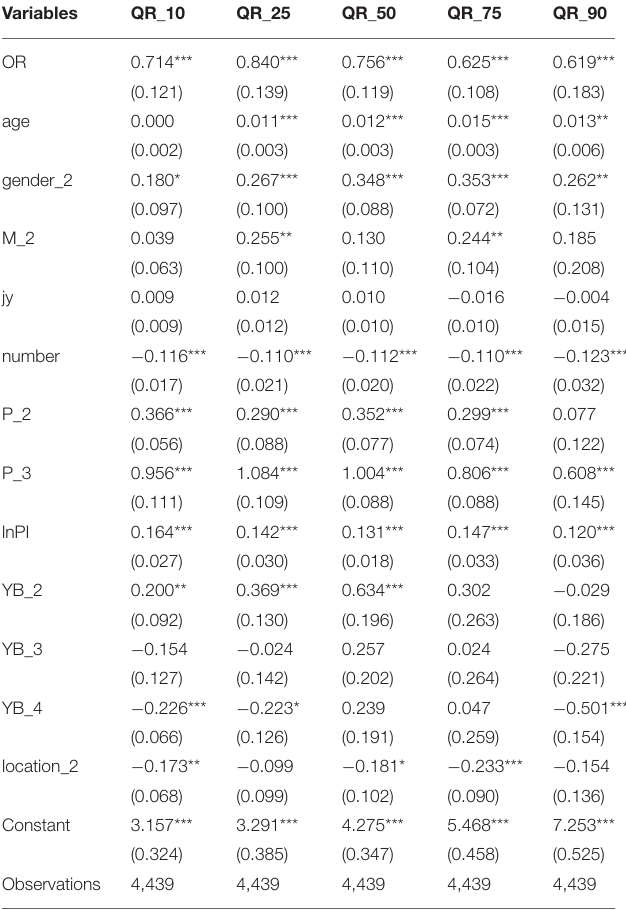
TABLE 5 | Regression results of household health expenditure in the central region.